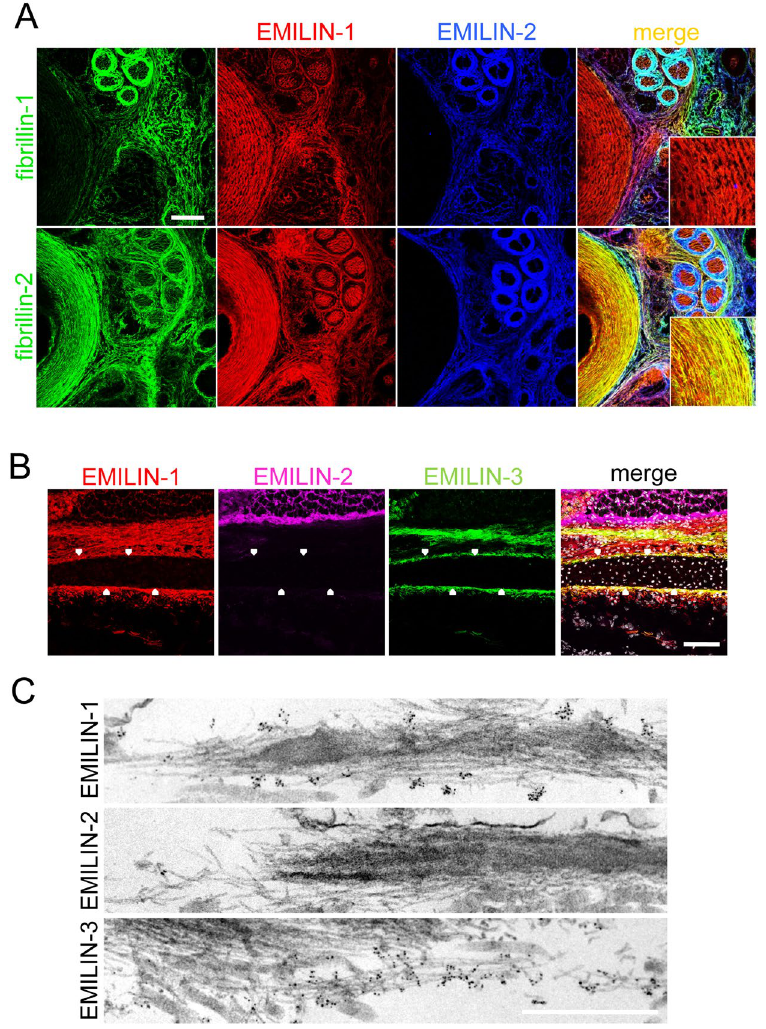
Figure 1. Localization of EMILINs in cartilage and bone. ( A ) Confocal immunofluorescence microscopy showing EMILIN-1 and -2, together with fibrillin-1, and -2 localization in transverse sections from newborn mouse tail. Each protein showed a specific distribution pattern among the different tissues present in the tail. However, signals detected for EMILIN-1 and -2 and fibrillin fibers were consistently overlapping. The insets in the merged panels show a higher magnification of the annulus fibrosus, where EMILIN-1 and fibrillin-2 fibers show co-localization. Scale bar: 75 μ m. ( B ) Sagittal section of newborn mouse skull, showing the localization of the three EMILIN proteins by immunofluorescence in calvarial bone. Note the presence of EMILIN-1 and EMILIN-3, but not EMILIN-2, positive fibers in the ECM that directly surround the bone (arrowheads). Scale bar, 75 μ m. ( C ) Transmission electron microscopy analysis of newborn mouse trachea, following immunogold labeling for the three EMILIN proteins (black dots). EMILIN-1 and EMILIN-3, but not EMILIN-2, are abundantly distributed on microfibrils. Scale bar, 500